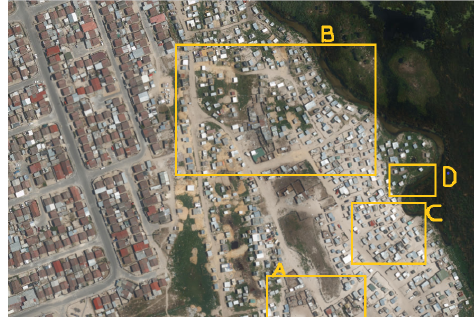
Figure 1. Aerial imagery of Khayelitsha Township in Western Cape, South Africa, obtained through a WMS service published by the City of Cape Town